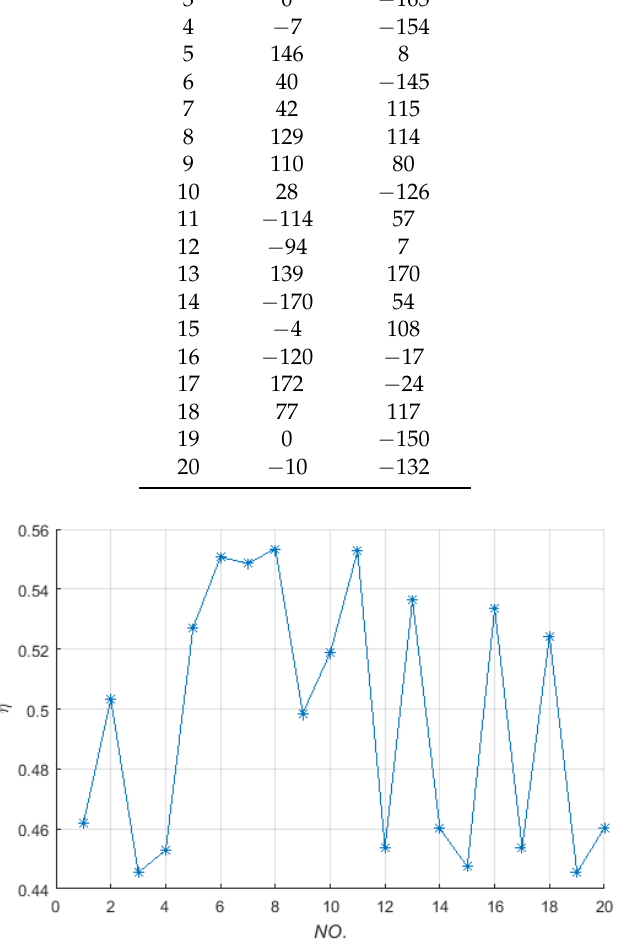
Figure 8. The power transfer efficiency versus the receiving coil distributed on the different tangent plane of the green spherical surface (radius is 0.4 m).